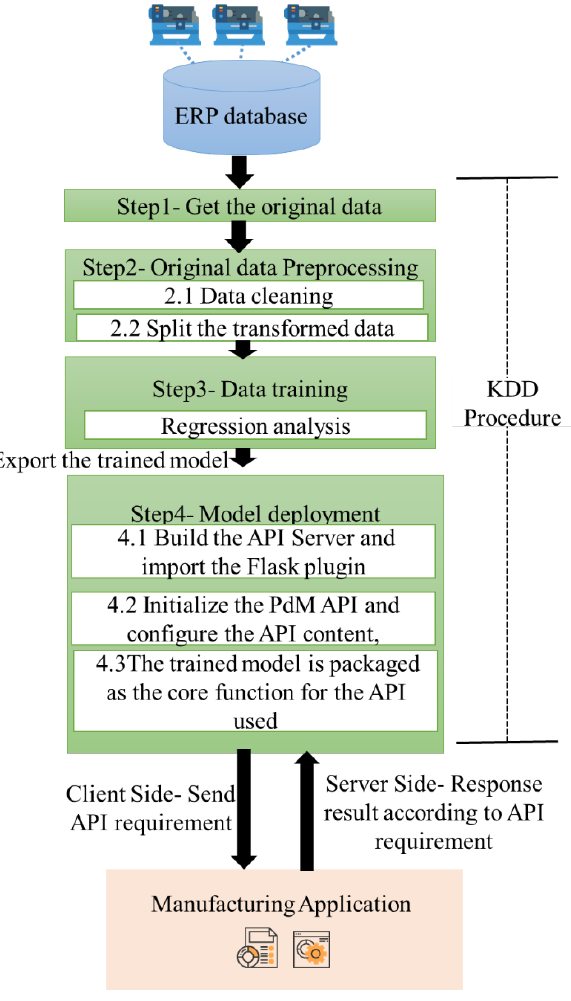
Figure 7. Procedure of model deployment.